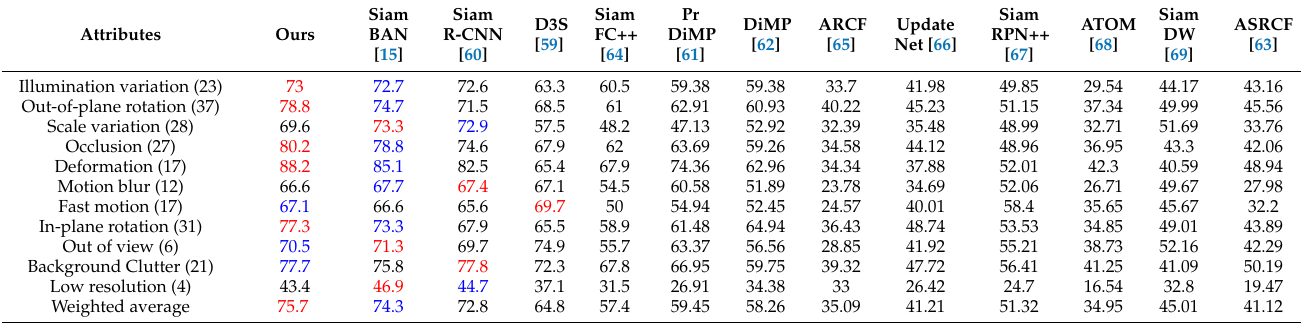
Table 2. Overlap success scores (%) in terms of individual attributes on the OTB-100 dataset.